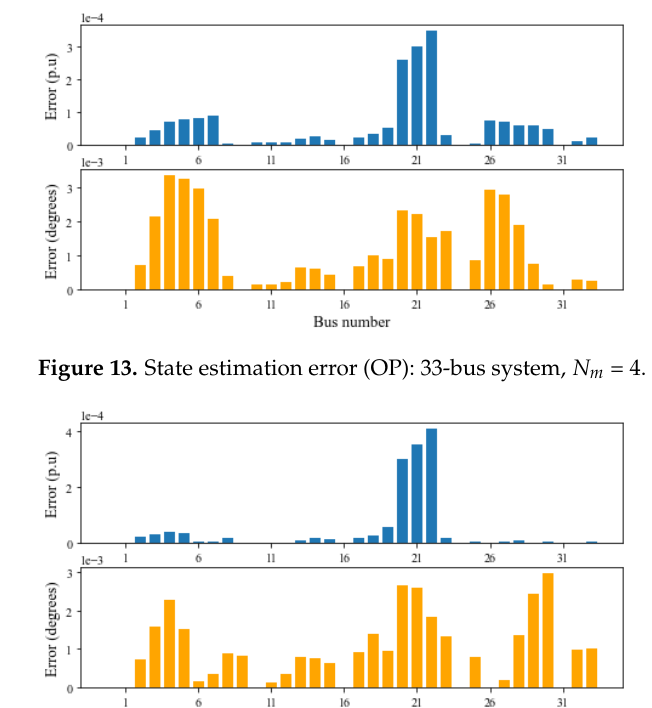
Figure 12. State estimation error (OP): 33-bus system, N m = 3.